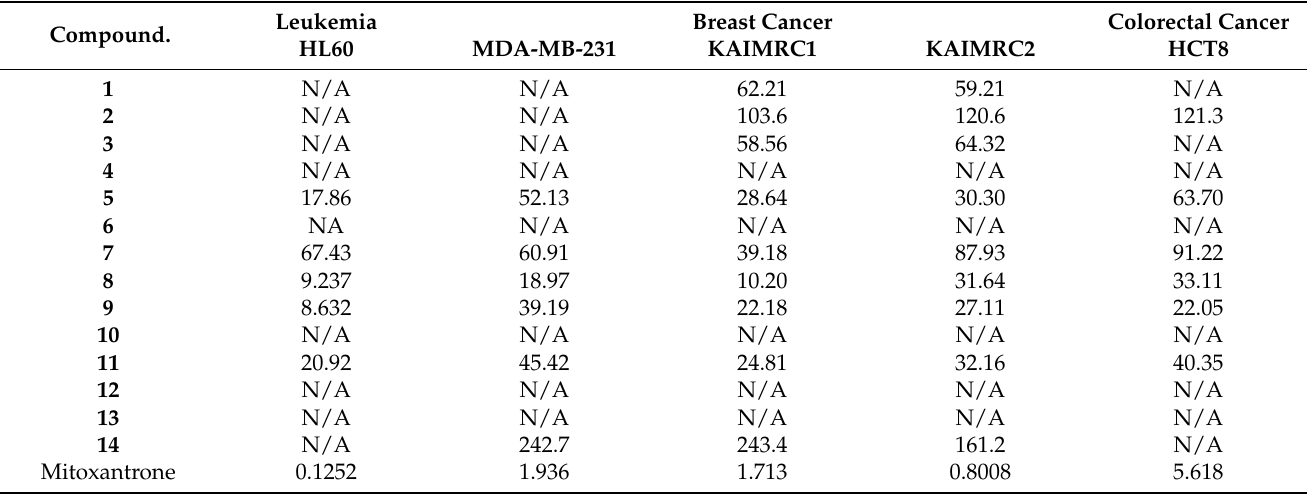
Table 2. The IC 50 ( µ M) of nitrogen-based derivatives against five cancer cell lines obtained using the CellTiter-Glo